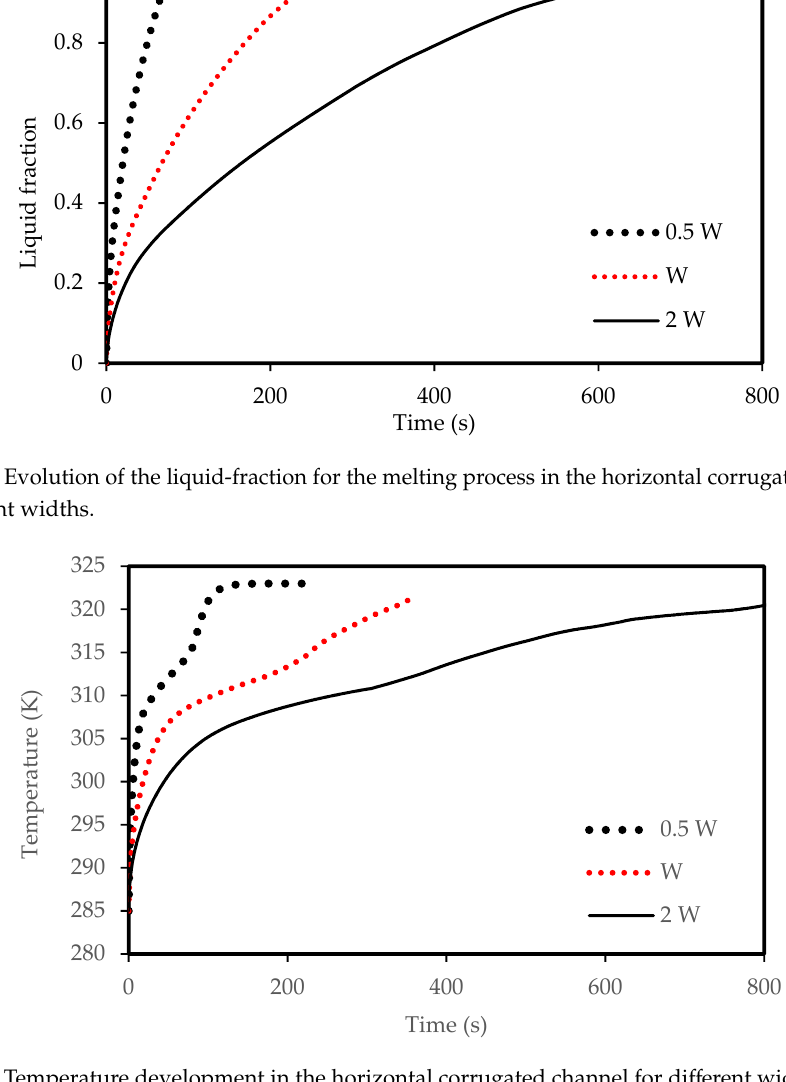
Figure 13. Temperature development in the horizontal corrugated channel for different widths for the melting process.